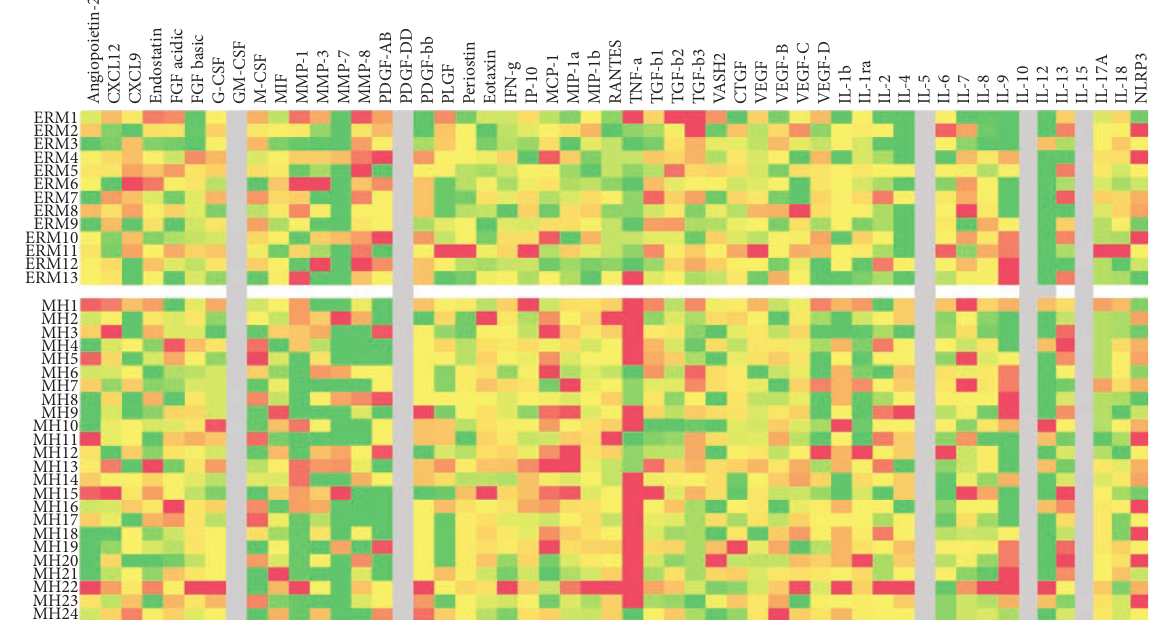
Figure 3: Visualization of the intergroup differences using a heat map chart for all 52 cytokines. Red indicates high expression and green indicates low expression. GM-CSF, PDGF-DD, IL-5, IL-10, and IL-15 in vitreous are too low to be detected